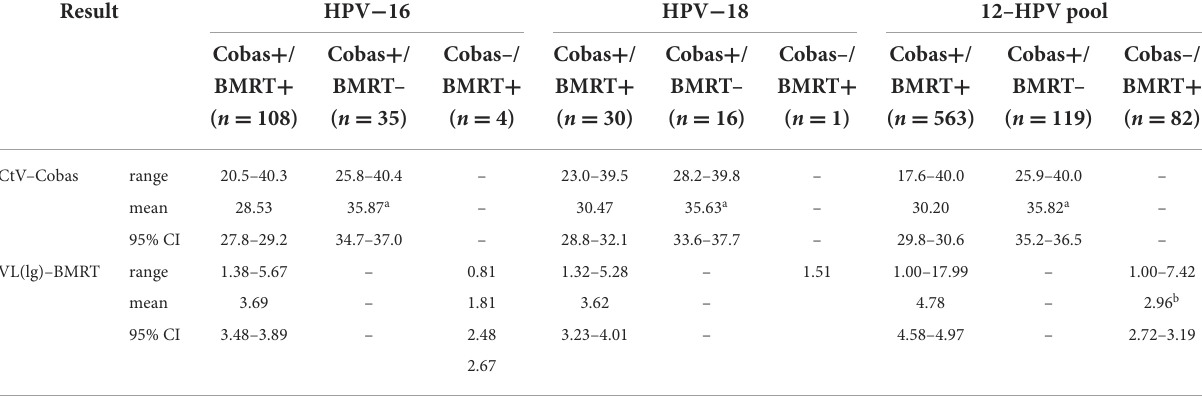
TABLE 1 Genotype-specific CtV and VL (lg) of the HPV-positive